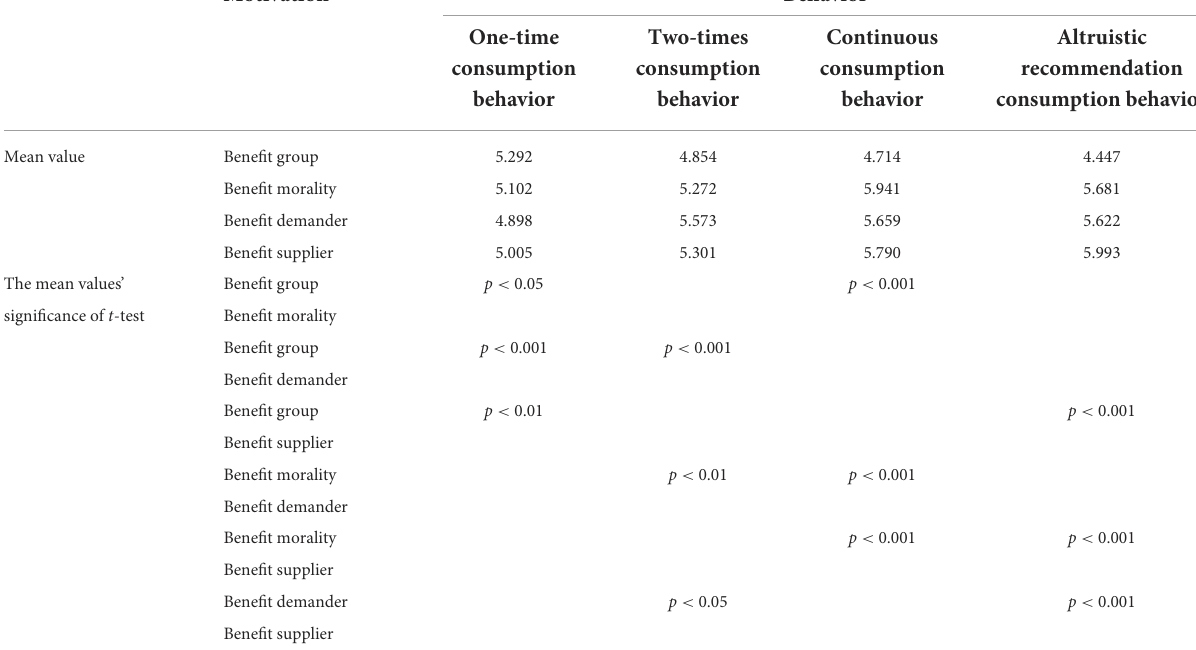
TABLE 4 Mean value and t -test of variable